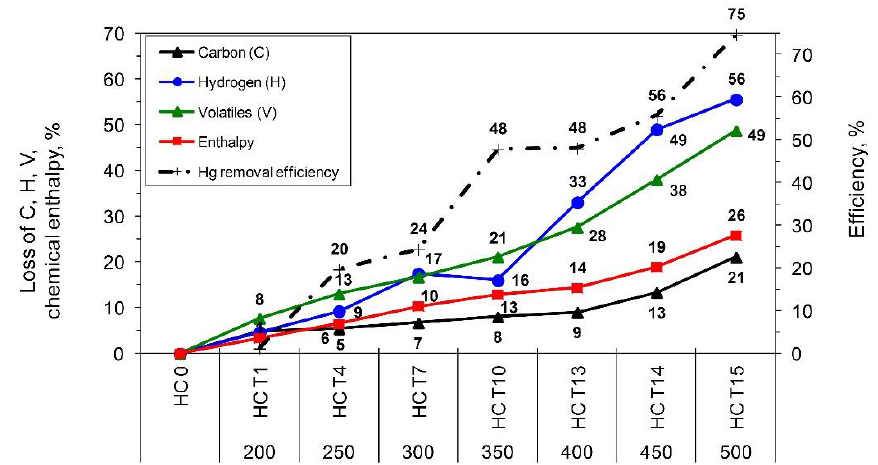
Figure 5. Average change of parameters and composition of refined fuel for hard coals; percentage loss content of C, H, and V, fuel chem. enthalpy vs. process temperature.